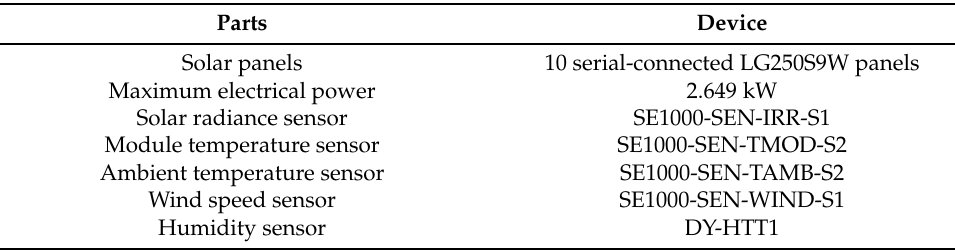
Table 1. Installed solar devices and PIoT sensors.